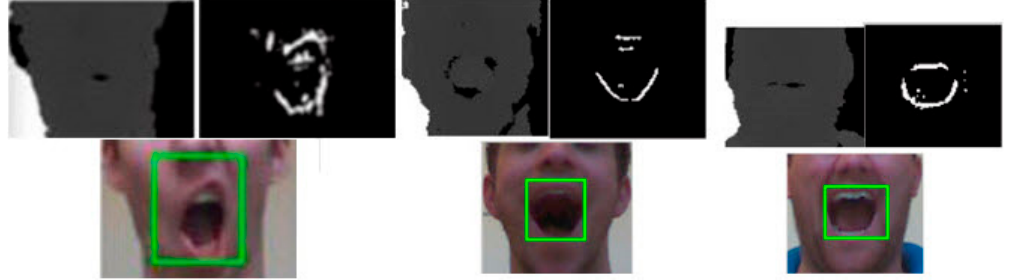
Figure 6. Results of detecting open mouths (second row) by applying the adaptive mask on the depth image (first row) for 4 different individuals.